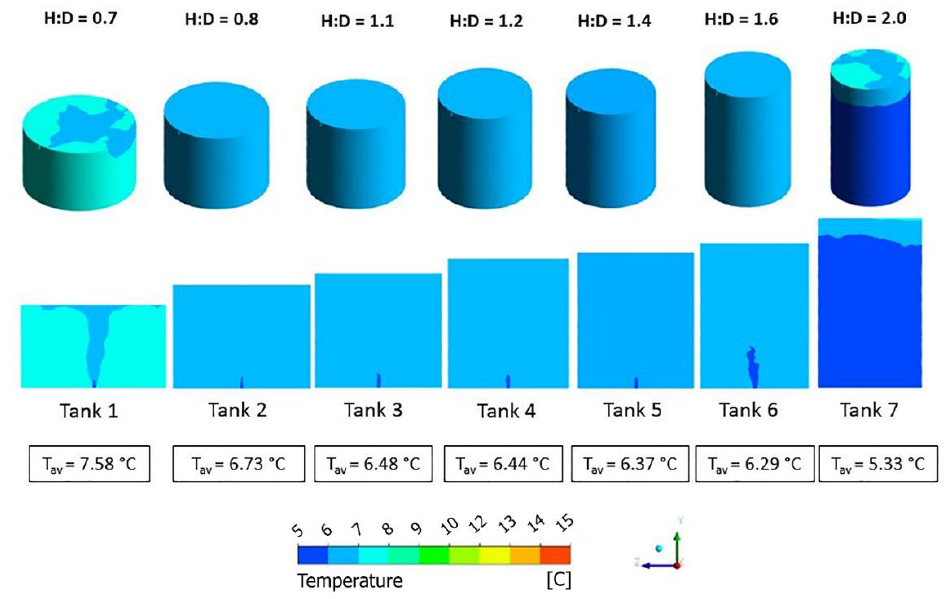
Figure 6. Variations of water temperature inside tanks after 11 h of charging.